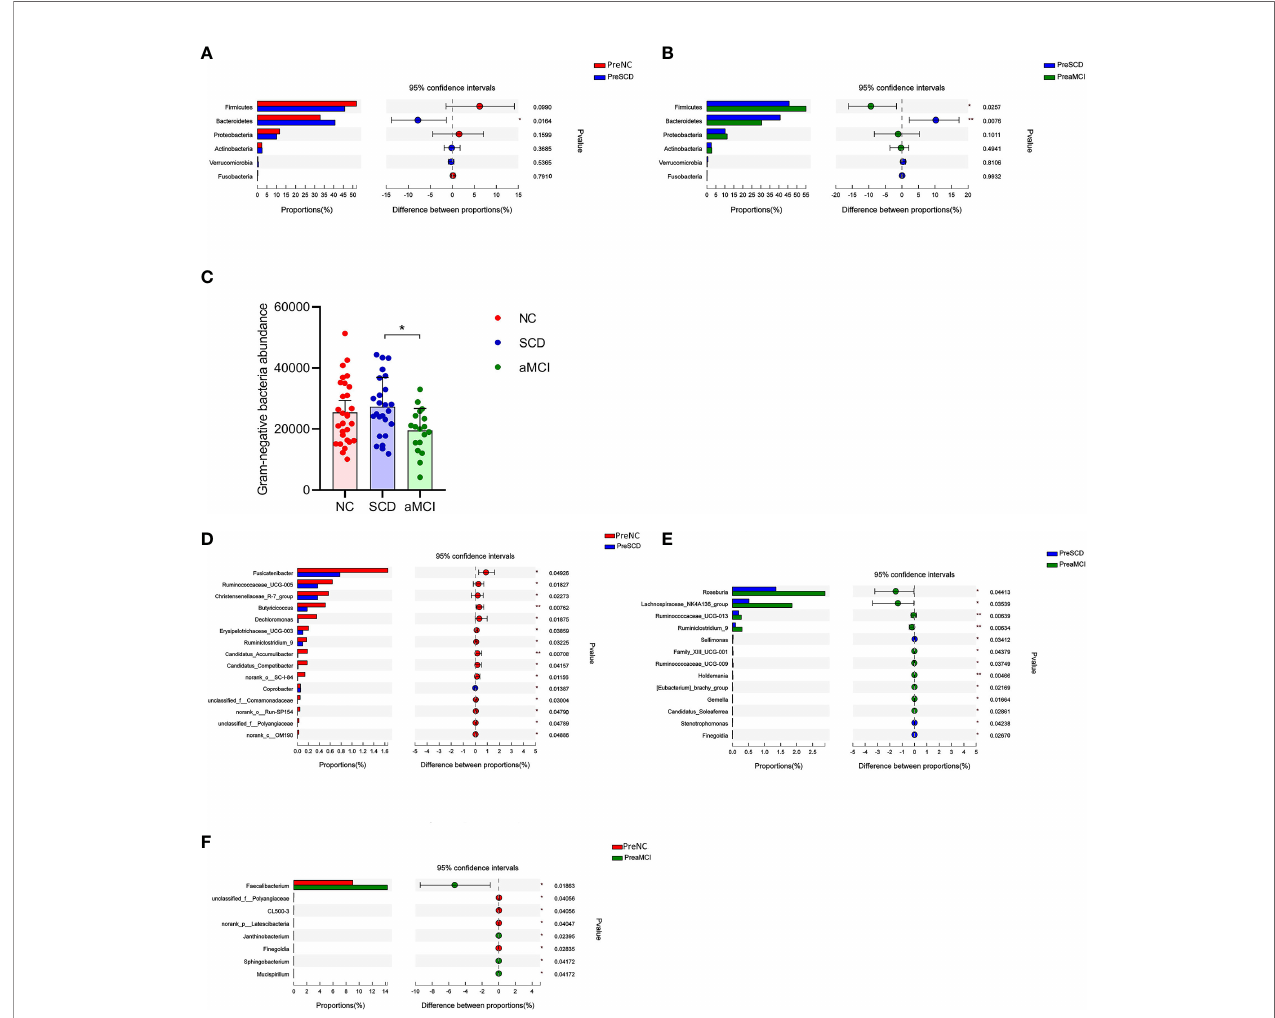
FIGURE 2 | (A – F) Relative bacterial abundance and differences from phylum down to genus levels between different cognitive groups (A – B) The vertical axis is the different bacteria phyla and the horizontal axis is the proportion of phyla in the sample. The columns with red, blue, and green colors represent the NC, SCD, and aMCI groups, whereas the length of the columns represents the proportion of the phyla. And the interval between the left and the right bar represents the 95% con fi dence intervals. There were more bacteroidetes in the SCD group than in the other two groups, and less Firmicutes than in the aMCI group (*P-value < 0.05, **P-value < 0.01, Wilcoxon rank sum test). (C) The horizontal axis is the cognitive groups and the vertical axis is the abundance of Gram-negative bacteria at the family level. The columns with red, blue, and green colors represent the NC, SCD, and aMCI groups respectively. Wilcoxon rank sum test showed that the abundance of Gram-negative bacteria at the family level was higher in the SCD group than that in the aMCI group (*P-value = 0.047, Wilcoxon rank sum test). (D – F) The vertical axis is the different bacteria genera and the horizontal axis is the proportion of genera in the sample. The columns with red, blue, and green colors represent the NC, SCD, and aMCI groups, whereas the length of the columns represents the proportion of the genera. And the interval between the left and the right bar represents the 95% con fi dence intervals. Wilcoxon rank-sum test shows that the differences in relative abundance of gut bacteria among the three groups were signi fi cant at the genus level (*P-value < 0.05, **P-value < 0.01, ***P-value < 0.005, Wilcoxon rank sum